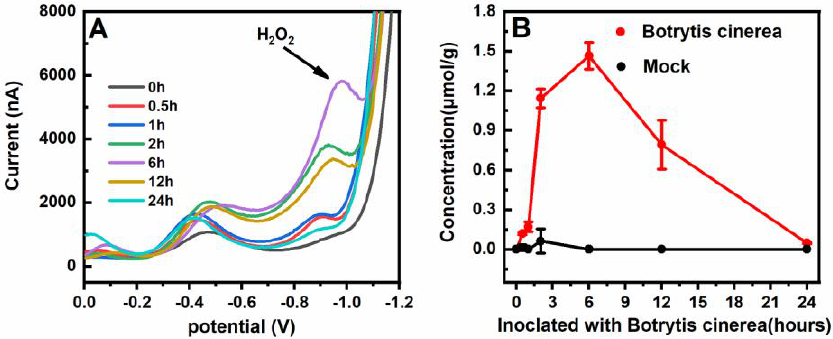
Figure 5. The typical di ff erential pulse voltammetry detection curves ( A ) and contents of H 2 O 2 ( B ) in Figure 5. The typical differential pulse voltammetry detection curves ( A ) and contents of H 2 O 2 ( B ) in tomato leaves at di ff erent times after being inoculated with Botrytis cinerea . The average values and Note: WE, work electrode; CE, counter electrode; RE, reference electrode; Hb/SWCNTs/CFUMEs, tomato leaves at different times after being inoculated with Botrytis cinerea . The average values and standard deviations were obtained based on 12 hemoglobin/single-walled carbon nanotubes/carbon fiber ultramicroelectrode; HRP/colloidal Au/ standard deviations were obtained based on 12 replicates. pPA/Pt electrode, horseradish peroxidase/colloidal Au/poly2,6-pyridinediamine/platinum wire electrode; HRP/Cys/AuNPs/ITO, horseradish peroxidase/L-Cysteine/gold nanoparticles/indium tin oxide; PtNPs/PAA/aSPCEs, poly (azure A)-platinum nanoparticles deposited on activated screen-printed carbon electrodes.